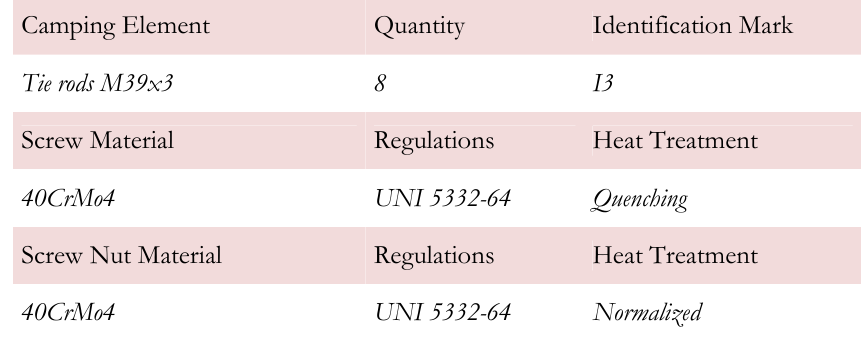
Table 1: Flange characteristics.